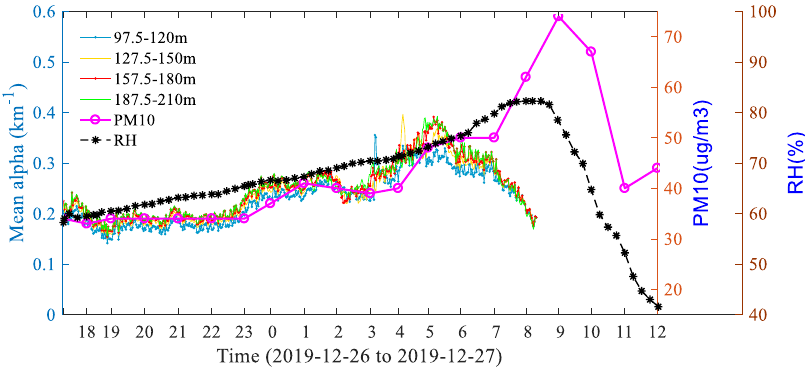
Figure 13. Temporal variation of the near-ground mean aerosol extinction coefficient (mean alpha), the PM10 concentration, and the relative humidity.